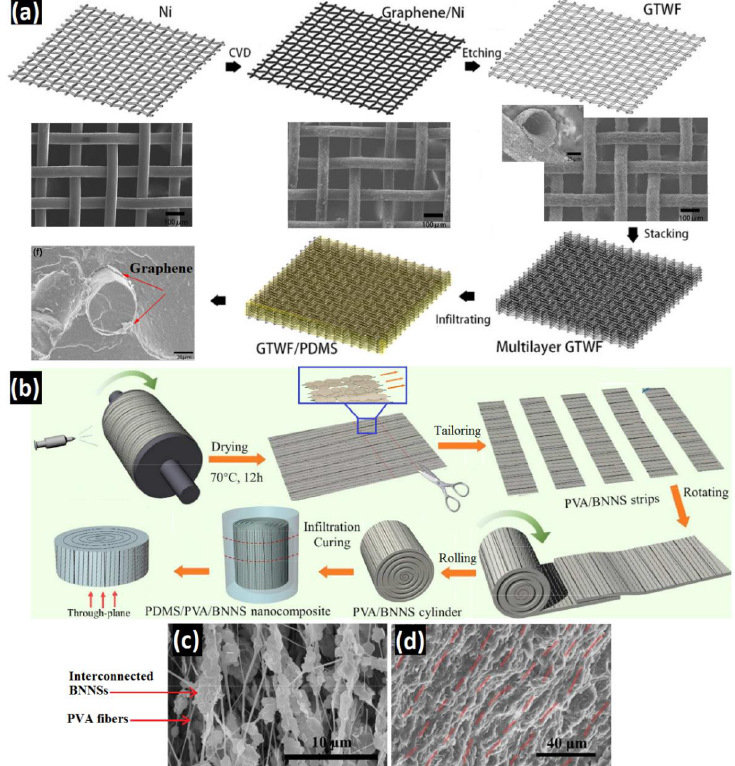
Figure 7. ( a ) Schematic illustration and SEM images of BNNSs/GTWF/PDMS composite (Reprinted with permission from WILEY-VCH, Copyrights 2019) [33]. ( b ) Electrospinning and